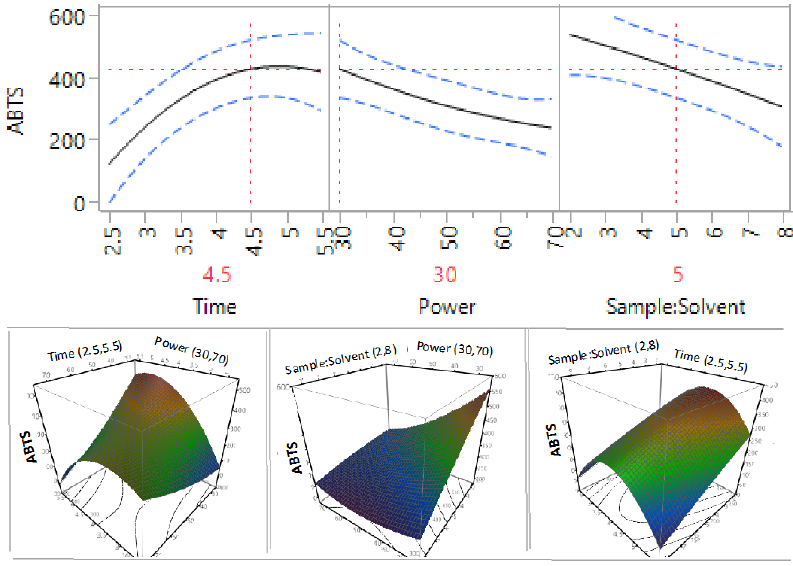
Figure 7. Impact of time (2.5–5.5 min), power (30%–70%, 360–840 W) and sample-to-solvent ratio (2–8 g/100 mL) on ABTS antioxidant capacity (µM TE/g).